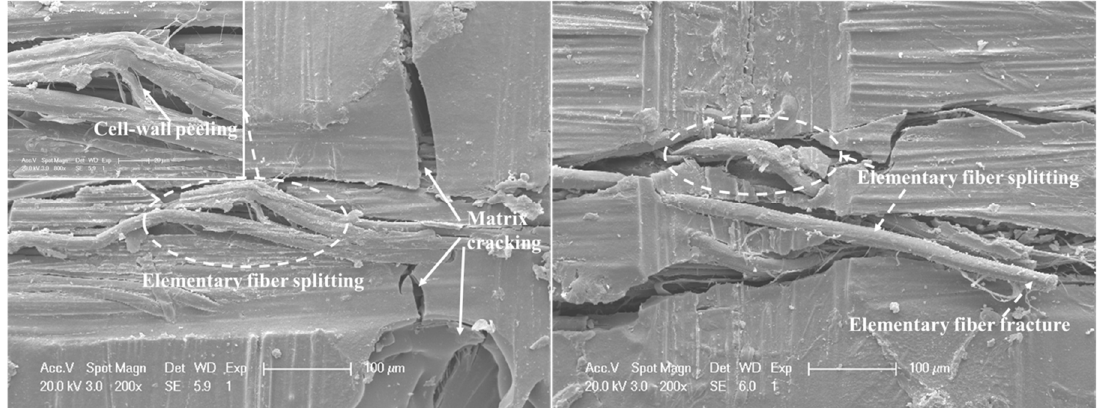
Figure 12. Micrograph of the damage initiation modes for the WA12W sample.